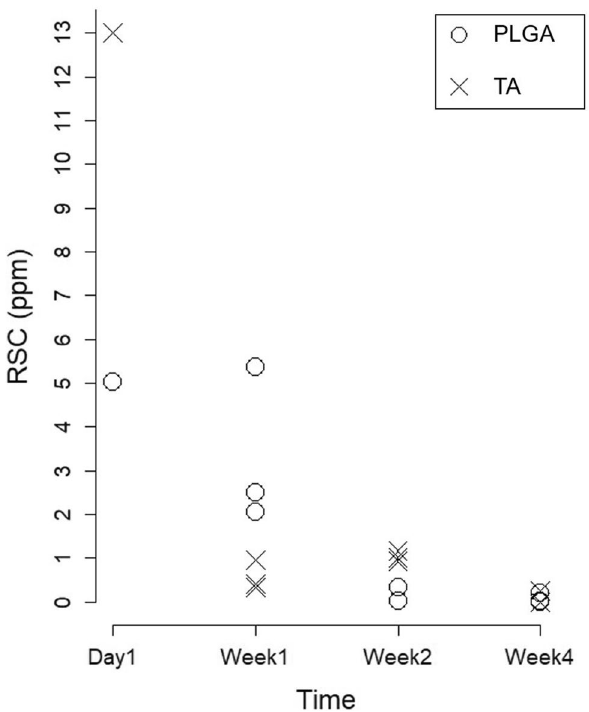
Figure 5. The RSC values of the injection segment in each time